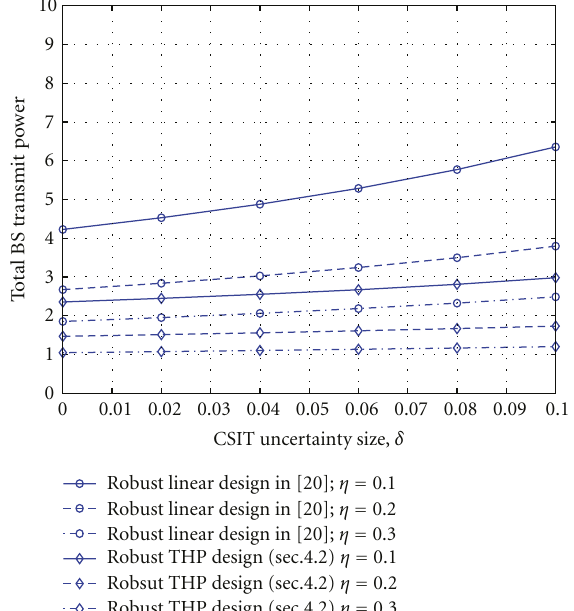
Figure 6: Total BS transmit power ( P T = (cid:3) B (cid:3) 2 F ) required as a function of CSIT uncertainty size, δ , to meet MSE constraints in the proposed robust design in Section 4.2 for the NBE model. N t = 4, N L M = 2, N = L = 2, maximum allowed MSEs r 1 = r 2 = 2, 1 2 η = η = η = 0 . 1,0 . 2,0 . 3, and δ = δ = δ . Proposed robust THP 1 2 1 2 transceiver design requires lesser BS transmit power than the robust linear transceiver design in [20].